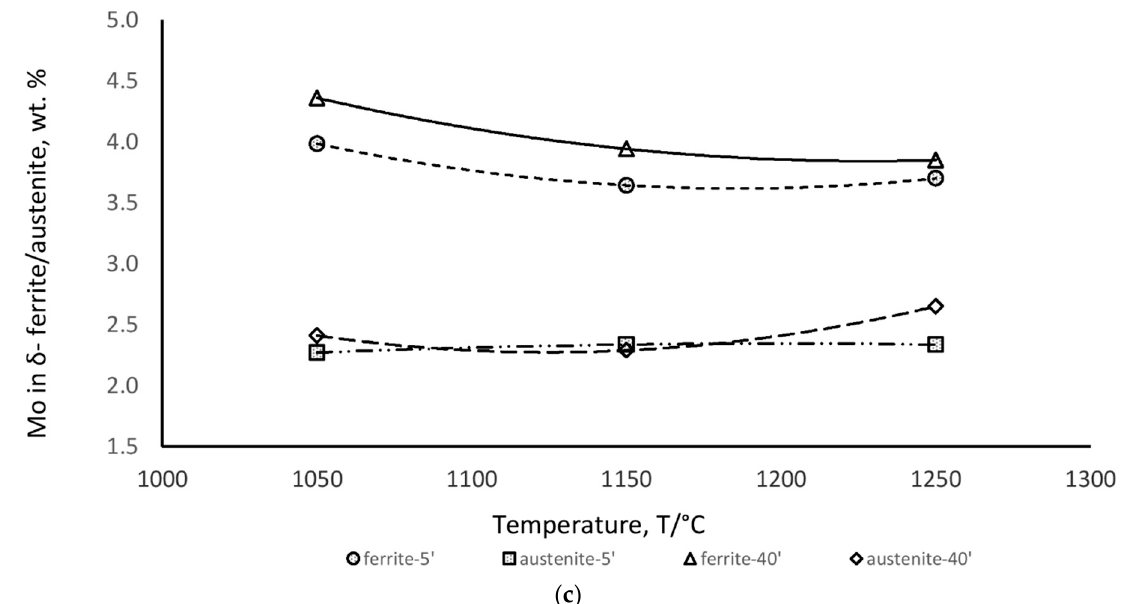
Figure 7. Content of chromium ( a ), nickel ( b ) and molybdenum ( c ) in the δ -ferrite and austenite depends on the temperature and time of annealing for the SS2343 stainless steel.